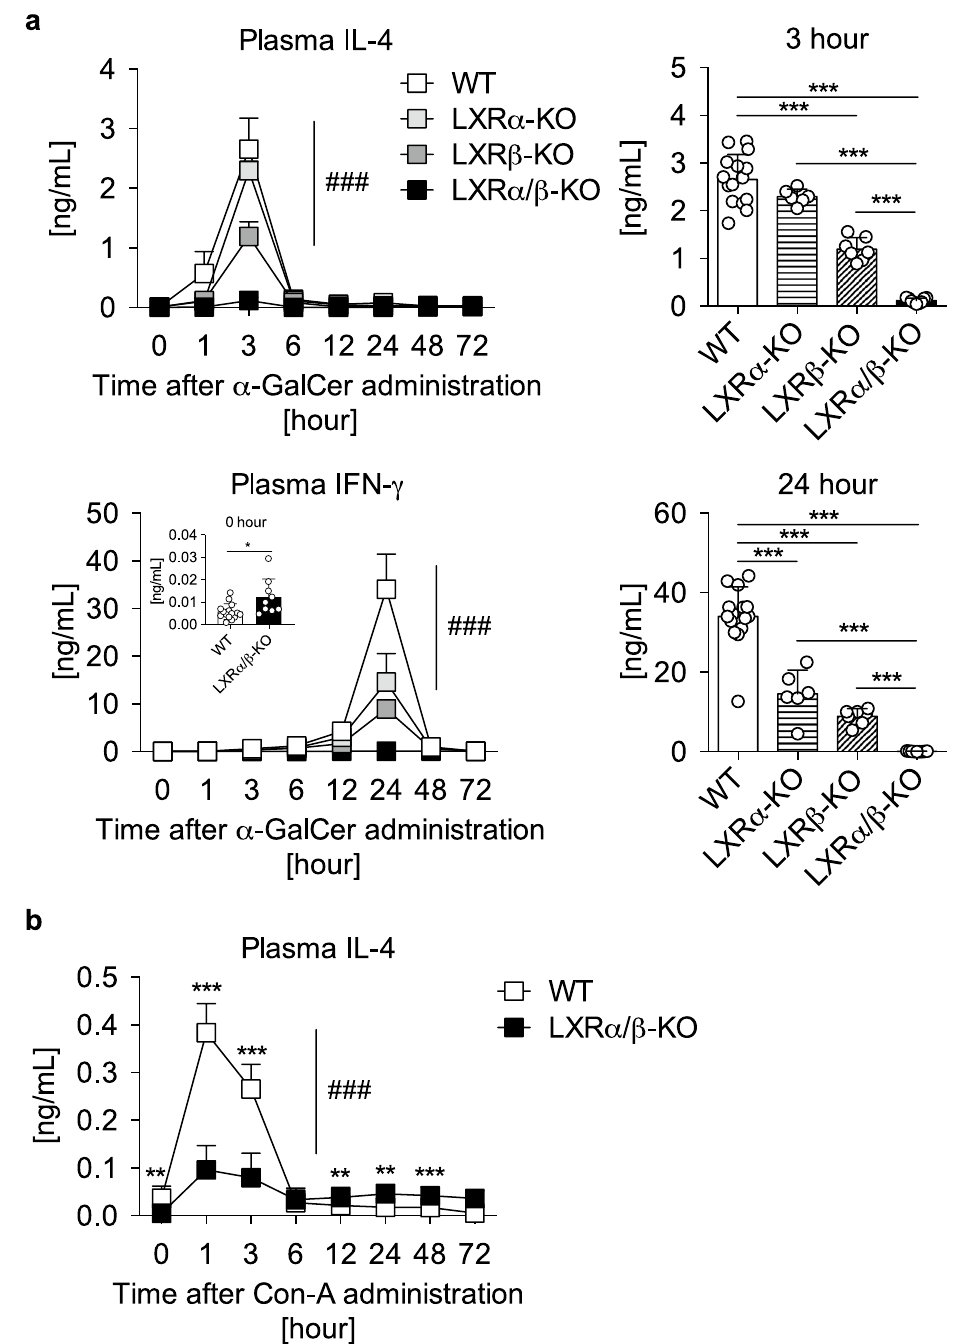
Figure 3. NKT cell-dependent cytokine production is impaired in LXRα/β-KO mice. ( a ) Plasma IL-4 and IFN-γ levels in mice treated with α-GalCer. WT (n = 15), LXRα-KO (n = 15), LXRβ-KO (n = 7) and LXRα/β-KO mice (n = 9) were injected with α-GalCer (0.1 mg/kg of body weight) intravenously, and plasma concentrations of IL-4 and IFN-γ were measured at the indicated time points. An inset panel in plasma IFN-γ shows the concentrations at the 0 h (unstimulated) time point. IL-4 levels at 3-h time point and IFN-γ levels at 24-h time point are also shown in bar graphs. ### P < 0.001 (two-way ANOVA). *** P < 0.001 (one-way ANOVA followed by Tukey’s multiple comparisons). ( b ) Plasma IL-4 levels in mice treated with Con-A. WT (n = 13) and LXRα/β-KO mice (n = 7) were treated with Con-A (12.5 mg/kg of body weight) intravenously, and plasma IL-4 concentrations were measured at the indicated time points. ### P < 0.001 (two-way ANOVA). ** P < 0.01, *** P < 0.001 compared to WT at the same time point (Student’s t